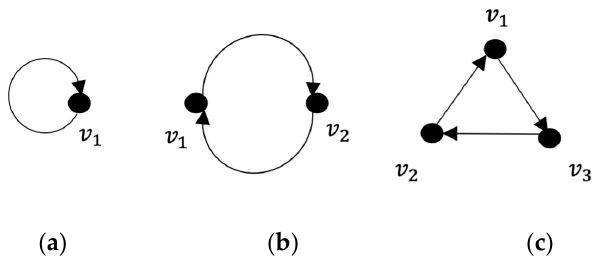
Figure 2. ( a ) 1-cycle ACS ( b ) 2-cycles ACS ( c ) 3-cycles ACS.